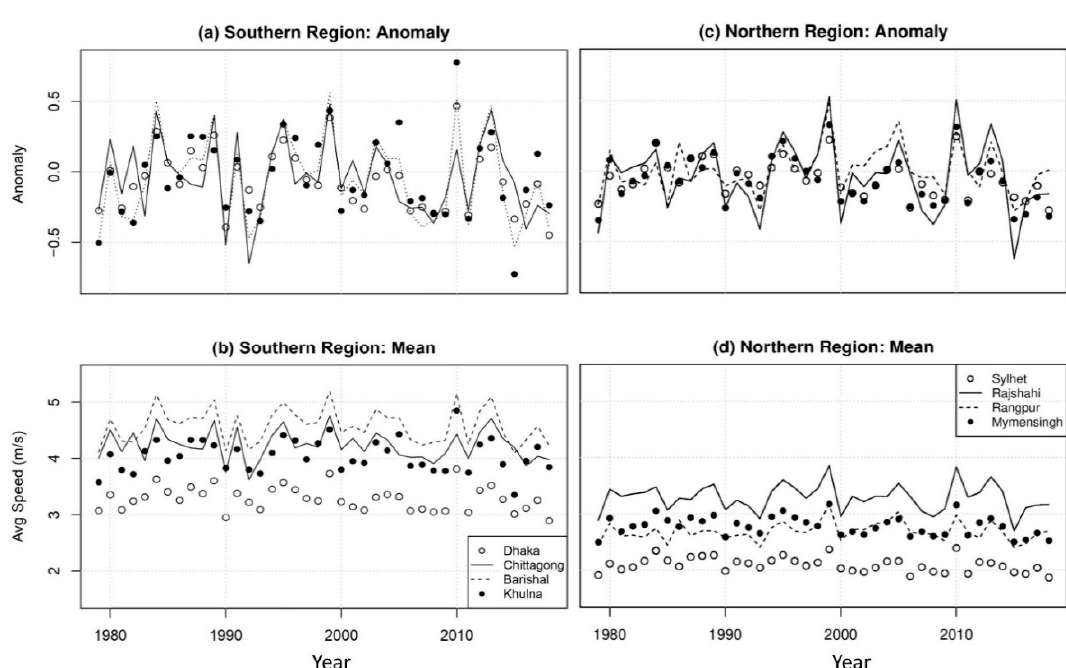
Figure 3. Same as in Figure 2, but valid for anomalies of wind speed.